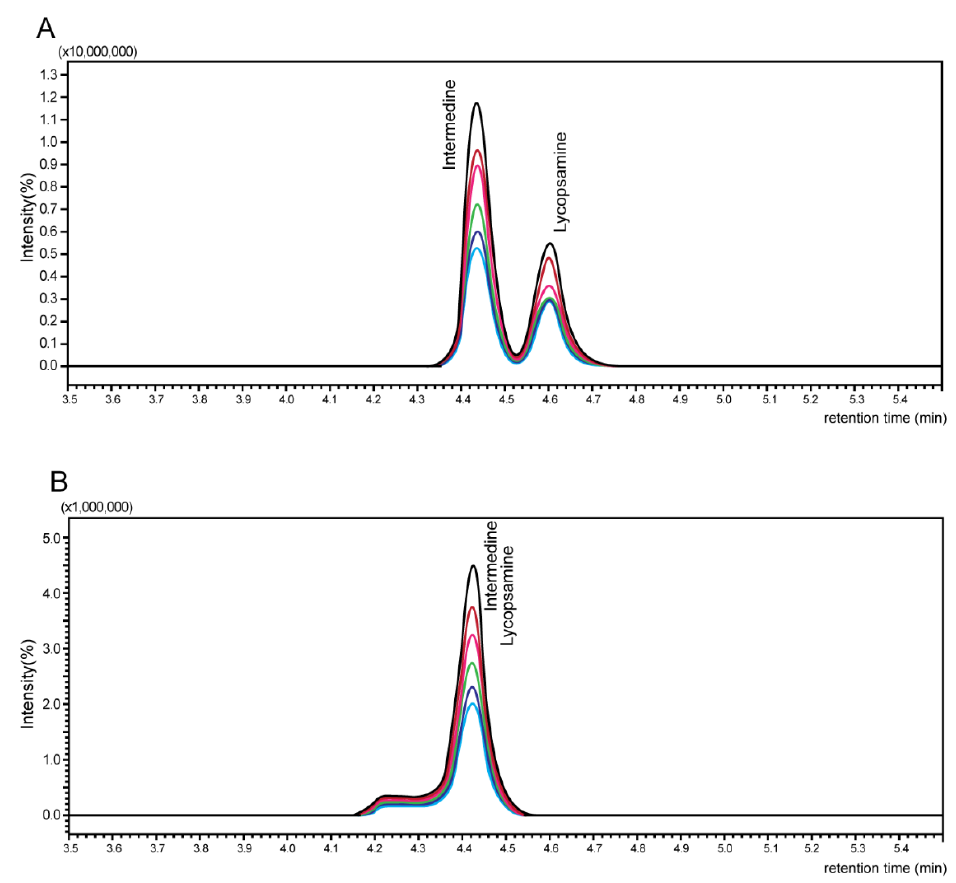
Figure 3. Comparison of chromatogram using mobile phase solvents ( A ) 95% methanol and ( B ) 100% methanol.